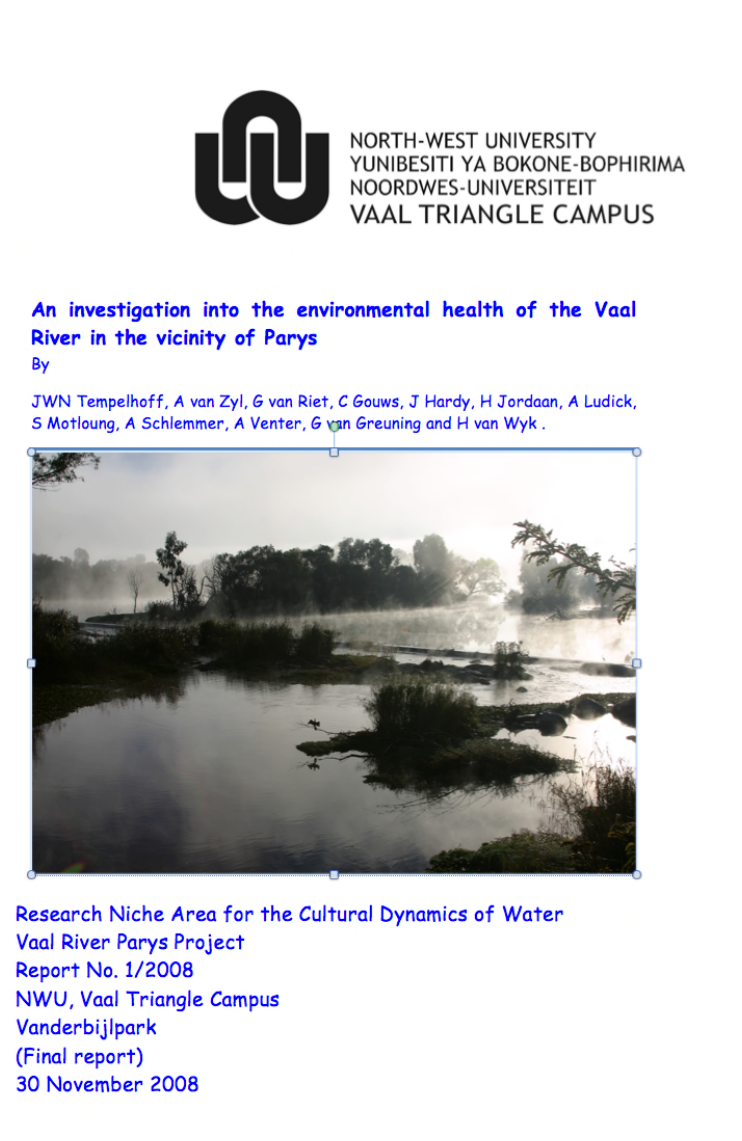
Figure 2 Ngwathe report